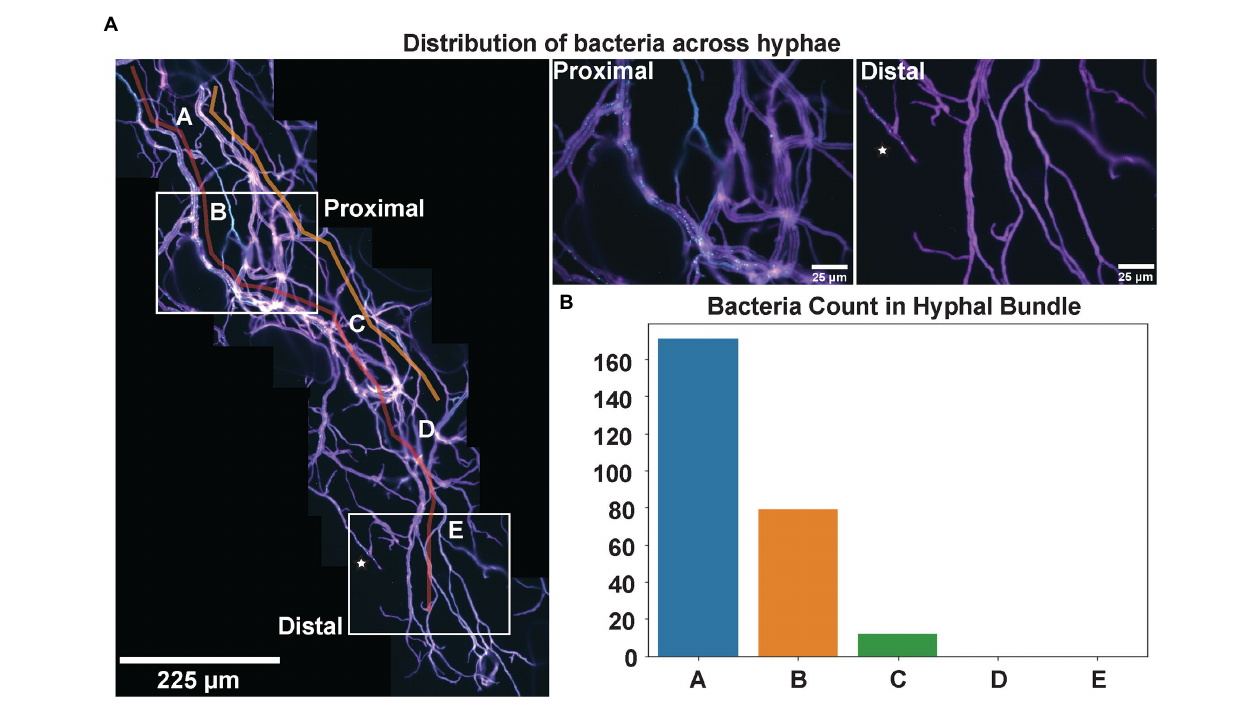
FIGURE 4 | (A) Mycoavidus (Cyan) observed across the length of P. verticillata (LANL.1351.123) hyphal bundles (Magenta) extending from the site of inoculation (Proximal) to the nascent hyphal tips away from the inoculation site (Distal). Guide lines highlighted in Red and Orange indicate hyphae of interest exhibiting high bacterial coincidence (Red) and low bacterial incidence (Orange). Hypha denoted by star in Distal end indicates a nascent strand that has greater accessibility for Mycoavidus to travel toward the tip. Higher magnification images of locations of the Proximal and Distal ends are provided on the right. (B) Mycoavidus count from several images throughout the hyphal bundle (denoted A–E) outlined in Red showing decreasing bacterial observations toward the hyphal